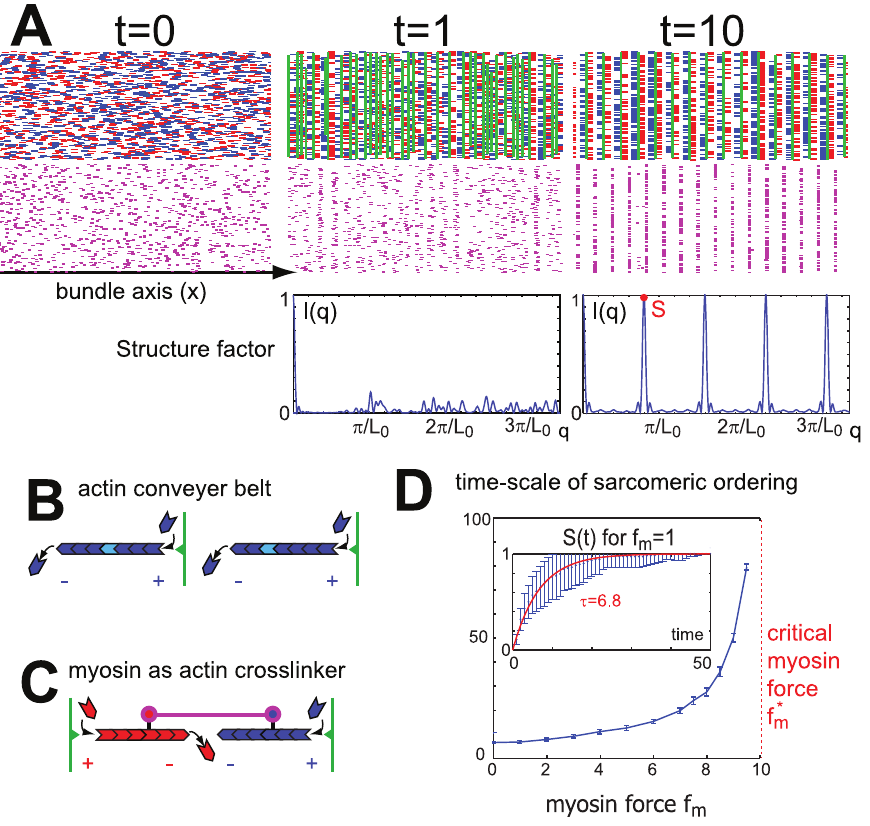
Figure 3. Sarcomeric ordering in the presence of myosin. A. Simulation snap-shots showing the emergence of sarcomeric order in an acto- myosin bundle ( single actin filaments: blue and red, myosin filaments: magenta, plus-end crosslinker connecting actin filament plus ends belonging to one cluster : green). Actin filaments can interact if their projections on the bundle axis overlap. Additionally, bipolar myosin filaments (magenta) dynamically attach to actin filaments in a polarity-specific manner, thus acting as a second set of active crosslinkers. Different vertical positions of the filaments are indicated solely for visualization purposes. Initially, filament positions are random ( t ~ 0 ). After a transient period during which clusters of crosslinked actin filaments form and coalesce ( t ~ 1 ), a stable configuration is established characterized by a periodic pattern of actin clusters interspersed by bands of aligned myosin ( t ~ 10 ). To characterize sarcomeric order in these simulated bundles, we compute the structure factor I ( q ) as defined in the main text (blue curves in lower panel, simulation time t ~ 1,10 , respectively). The height of the principal Bragg peak (red circle) defines the sarcomeric order parameter S . The active myosin force that tends to oppose sarcomeric ordering was chosen as f m ~ 1 , measured in units of c a L 0 v 0 . An animated version of this simulation can be found as Video S1 available online as Supplementary Information. B. Illustration of the ‘actin conveyer belt’ mechanism: Actin filaments that are grafted at their plus-end by a processive crosslinker have to polymerize against the crosslinker (that acts as an obstacle) and are pushed backwards in a form of local retrograde flow. Myosin filaments interacting with these treadmilling actin filaments are transported away from the cluster center provided that the actin treadmilling speed exceeds the active myosin walking speed. C. Myosin filaments that are attached to actin filaments from two neighboring clusters serve as an active crosslinker and mediate repulsive forces between the two clusters due to the difference in the actin polymerization forces and the myosin active forces, see also SI text S1. D. Myosin active force slows-down sarcomeric ordering: The inset shows the time-course of the sarcomeric order parameter S ( t ) (blue,mean + s.e., n ~ 100 ) for f m ~ 1 , together with a fit of simulation results to an exponential saturation curve S 0 ½ 1 { exp( { t = t ) (cid:2) (red) that allows us to extract a time-scale t of . For myosin sarcomeric ordering. The main plot shows this time-scale t as a function of myosin force f m ; t diverges as f m approaches a critical value f (cid:3) m , sarcomeric order is not established. Instead, myosin forces facilitate the coalescence of crosslinked actin forces that are larger the critical value f (cid:3) m clusters into a small number of very large clusters (not shown), similar to the case shown in figure 2B without friction.